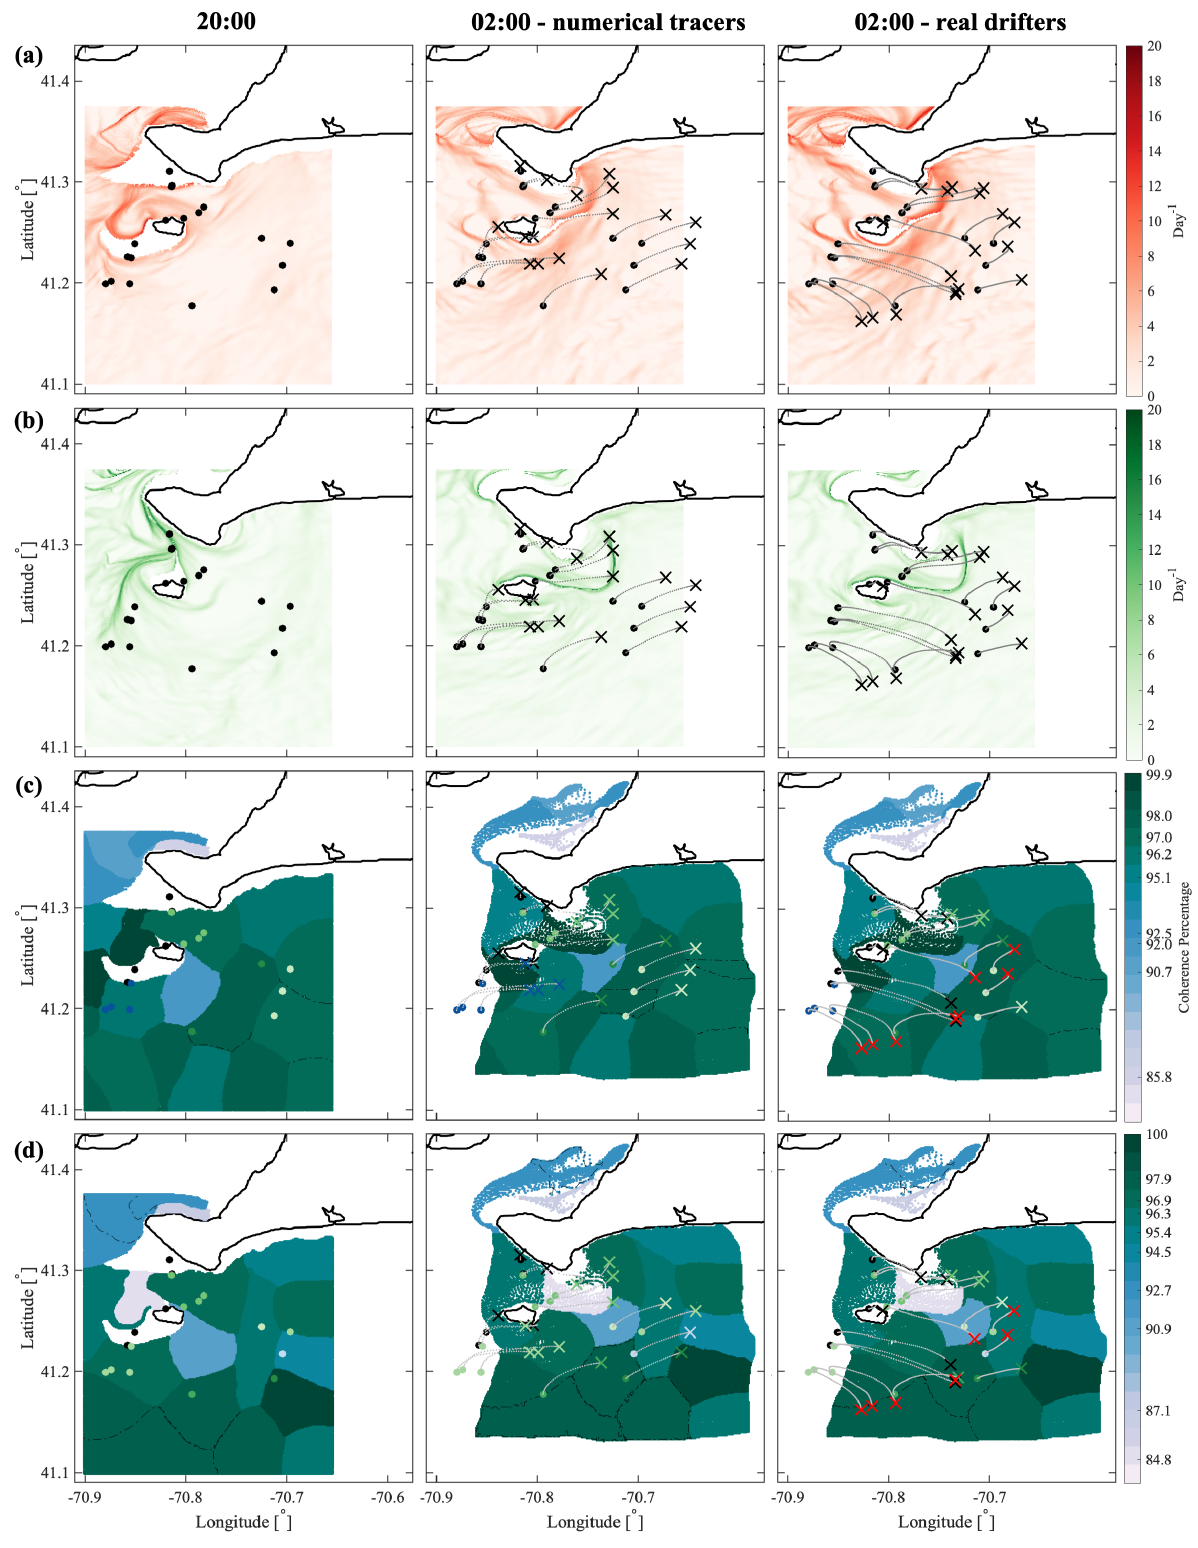
Figure 9. LCS, numerical tracers and drifter positions at the start (20:00 UTC) and end (02:00 UTC) of the 2018 experiment on August 7–8. ( a ) Forward and ( b ) backward FTLE. ( c , d ) Spectral clusters with coherence metric. The drifters are color-coded according to the cluster to which they belong, with red crosses if their final positions were outside their initial